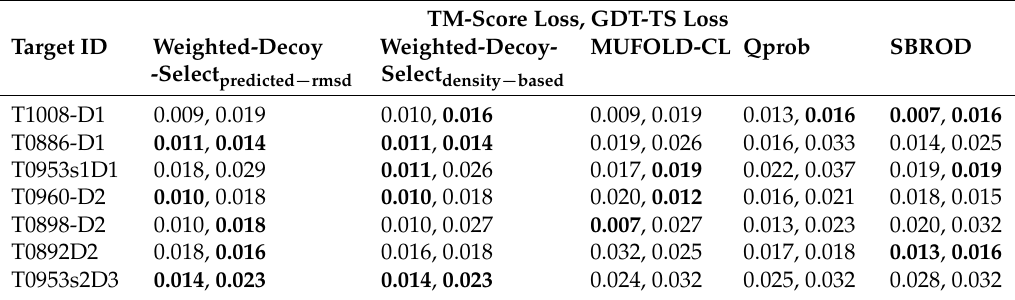
Table 4. Columns 2–6 relate template modeling-score and global distance test-total score loss obtained from Weighted-Decoy-Select predicted − rmsd , Weighted-Decoy-Select density − based , MUFOLD-CL , Qprob , and SBROD , respectively. Lowest loss per CASP target is highlighted in